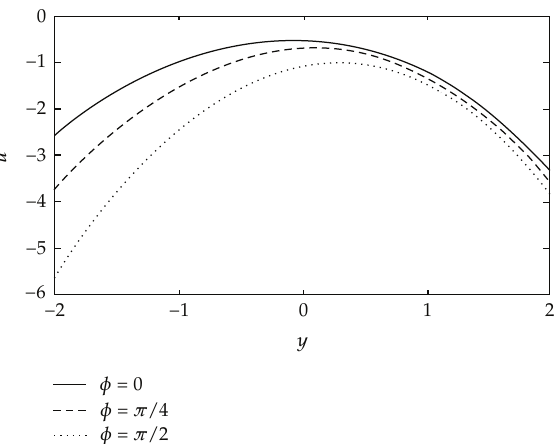
Figure 10: Axial velocity versus y at α (cid:9) 0 . 05, a (cid:9) 0 . 2, b (cid:9) 0 . 6, d (cid:9) 0 . 8, ε (cid:9) 0 . 2, λ 1 (cid:9) 1, Da (cid:9) 1, x (cid:9) π/ 2, and q (cid:9) − 1.